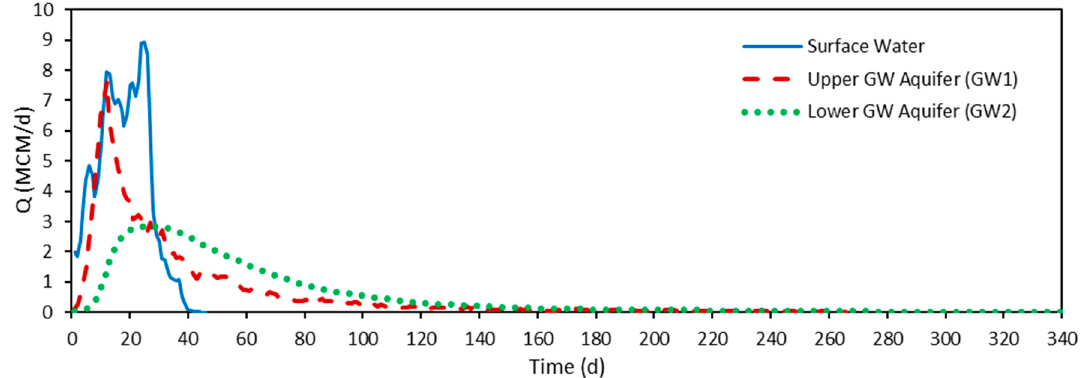
Figure 6. The developed response functions (i.e., unit hydrographs) of surface water, upper groundwater aquifer, and lower aquifer of the upper Blue Nile basin at Diem Station. Note that the groundwater responses are developed from both underground and over ground travel times.